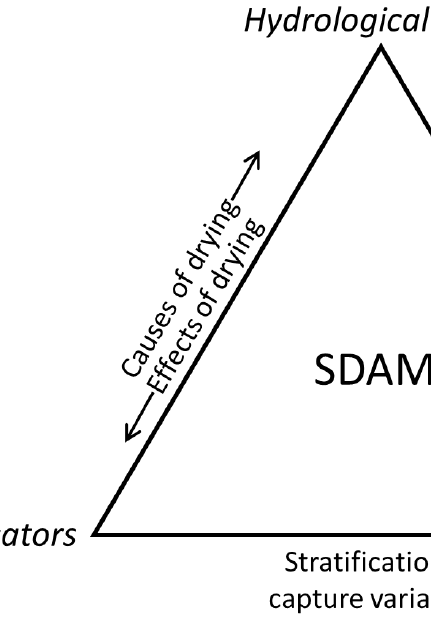
Figure 3. Key components of streamflow duration assessment methods (SDAMs) and their inter-relationships. The arrows moving from indicators to hydrologic data represent indicators that control stream flow duration, whereas the arrow moving from hydrologic data to indicators represent indicators that respond to stream flow duration. Applicability is the selection of study reaches reflecting the intended range of streamflow duration and hydrologic conditions for the developed SDAM. Stratification or regionalization captures variability to improve certainty in the SDAM classification.